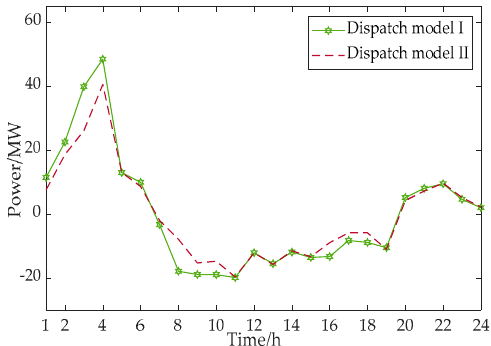
Figure 13. Comparison of demand response (DR).